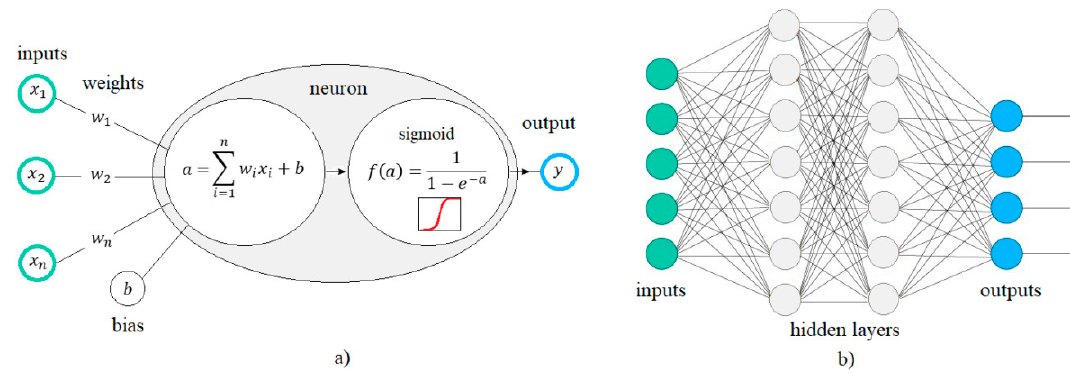
Figure 2. Example of a feed-forward ANN: ( a ) neuron, ( b ) architecture.